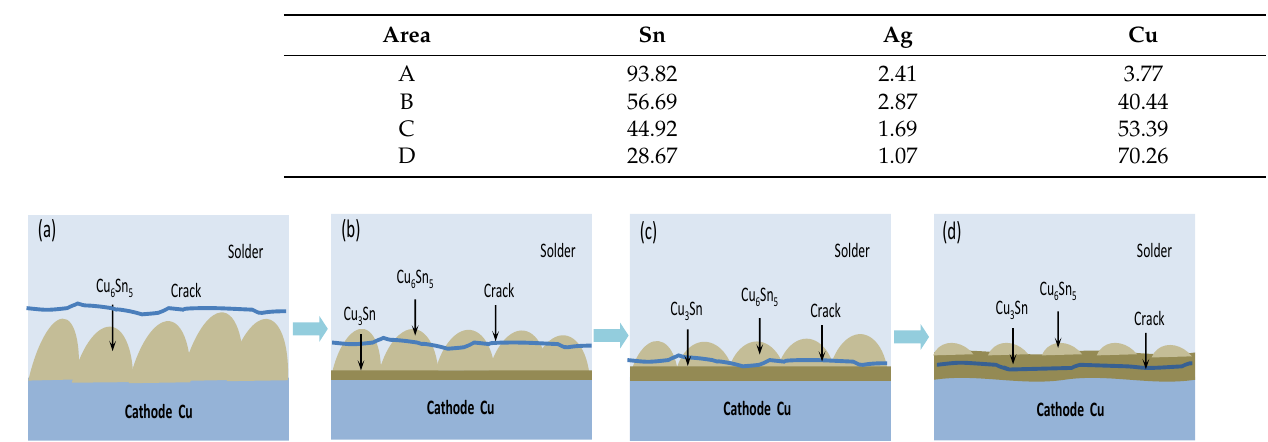
Table 1. EDS analysis of the marked area of shear fracture of solder joints in Figure 11 (At.%).